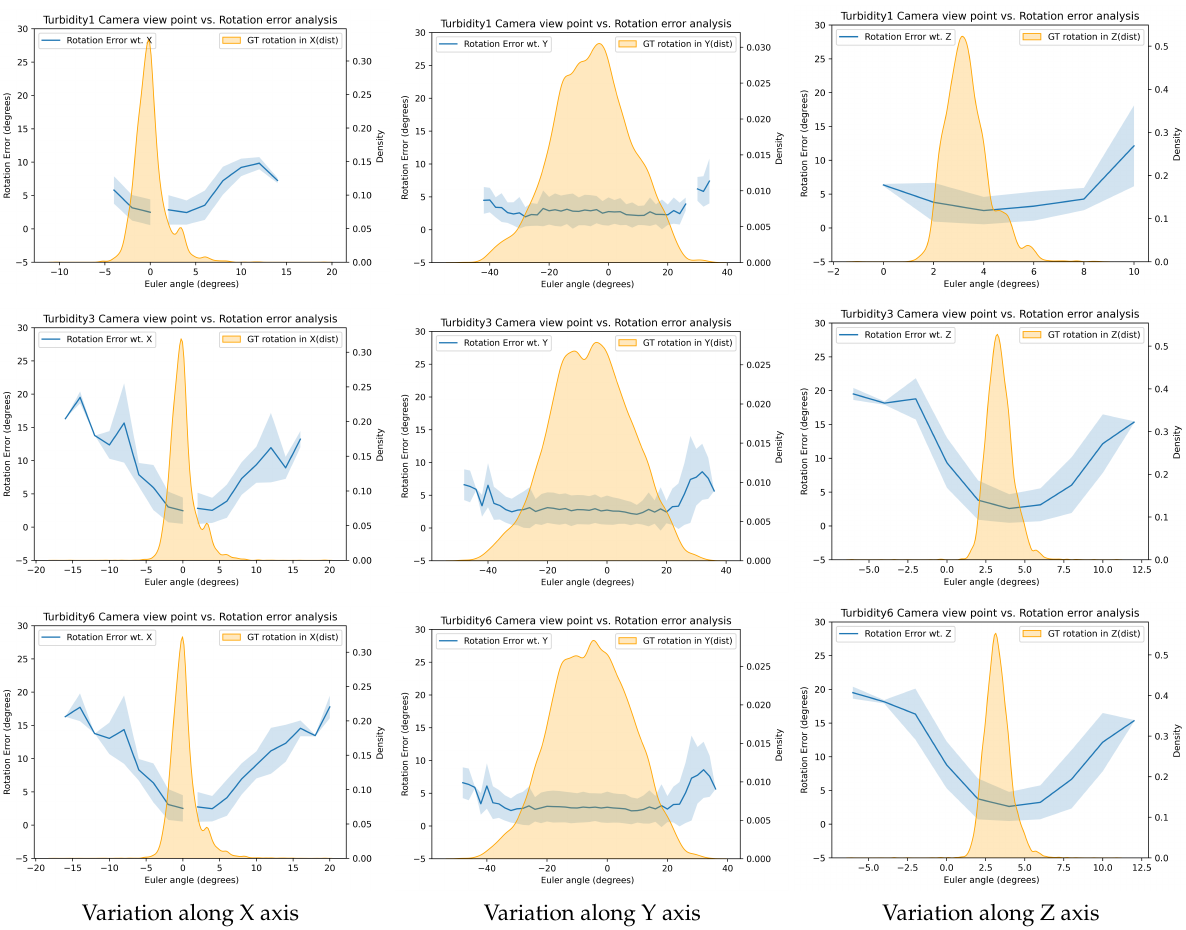
Figure 6. Fusion model pose estimation (rotation and translation) error with respect ground truth data distribution for various turbidities. The top, middle and last row shows ground truth rotation angles vs. error in rotation for turbidities 1, 3 and 6,